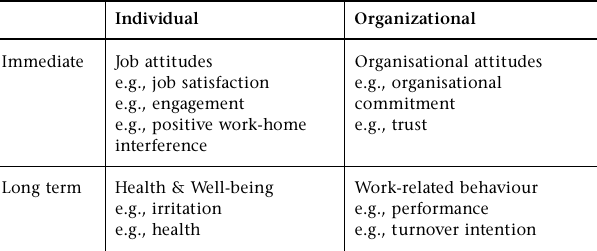
Figure 1: The outcomes of job insecurity (Sverke, Hellgren & Näswall,